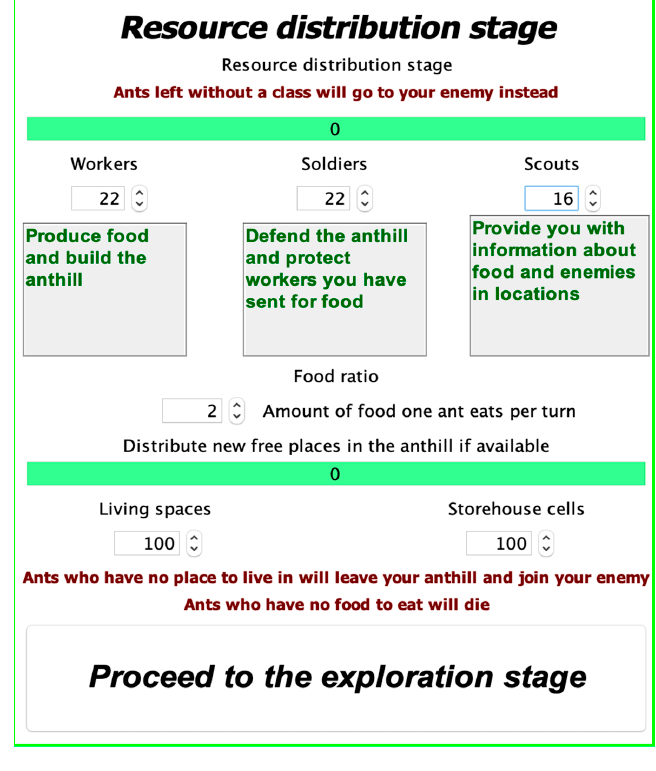
Figure A3. The resource distribution window.